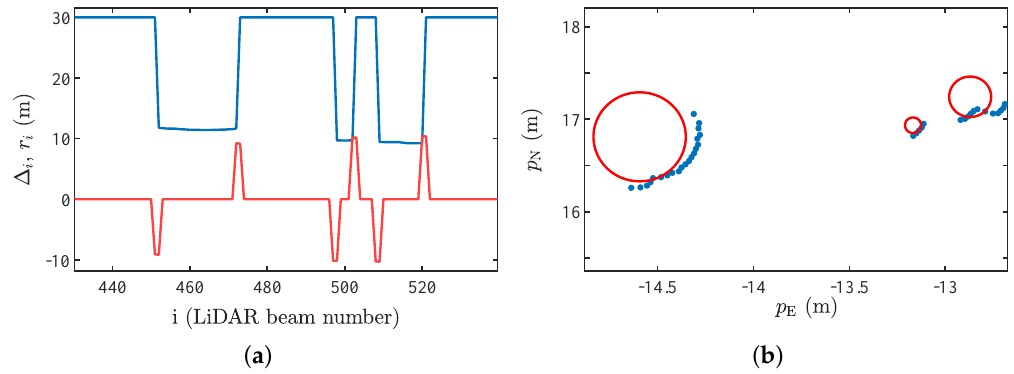
Figure 3. ( a ) Original laser scan in blue and the detected discontinuities in red. ( b ) Tree radius estimate. The blue dots represent the laser beams, and the tree trunks are represented by red